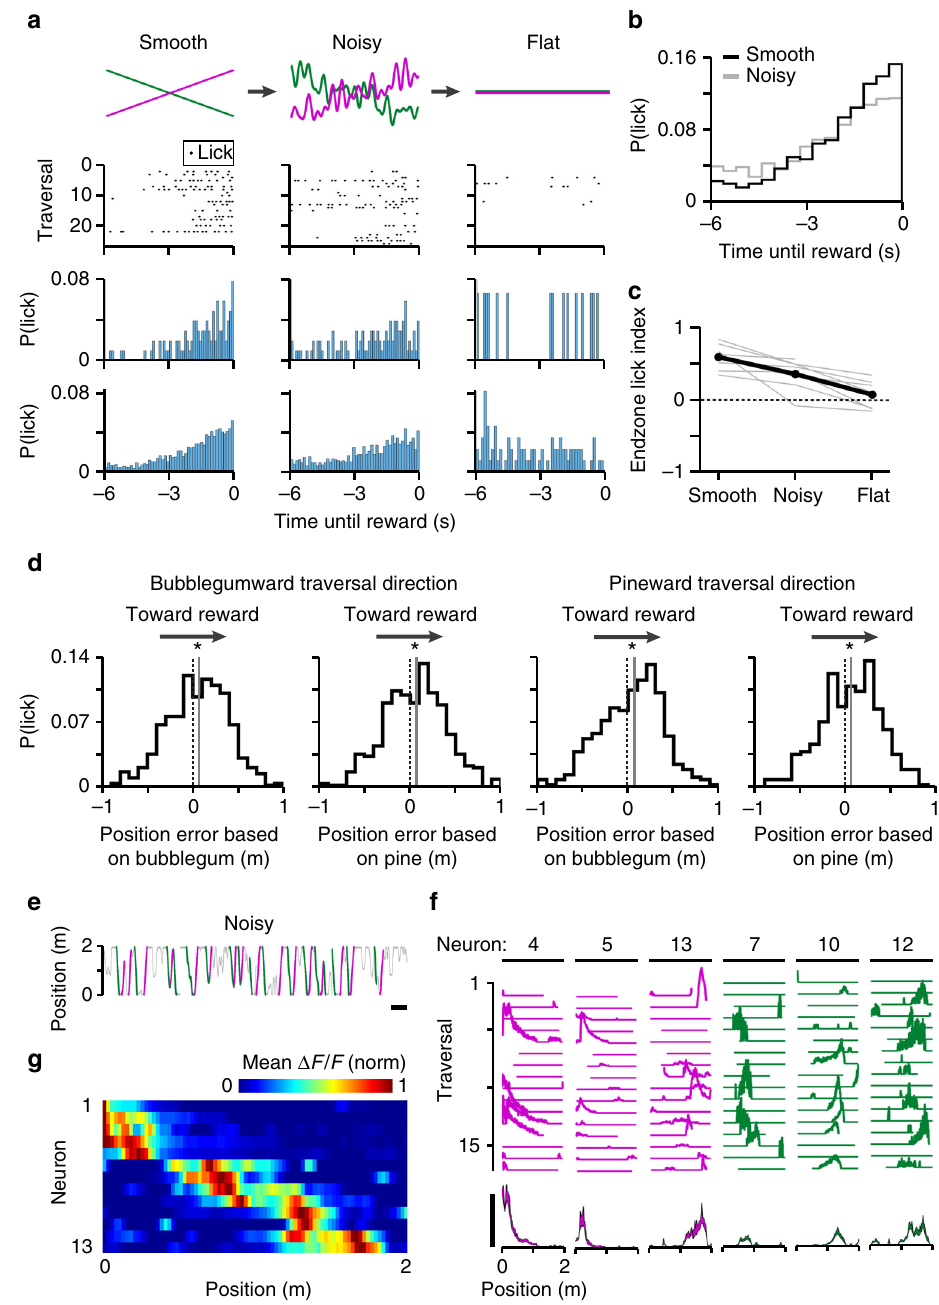
Fig. 6 Olfactory noise affects behavior and place cells are present during noisy odor navigation. a Mice were switched between familiar smooth, noisy, and fl at odor conditions (row 1). Example anticipatory licking raster plots (row 2) and corresponding histograms (row 3) for the same mouse in each condition. Pooled anticipatory licking histograms across all fi ve mice in eight sessions (row 4). b Overlaid anticipatory licking histograms from a bottom. Anticipatory licking was less precise and occurred earlier in the noisy vs smooth conditions. c Endzone lick index (Methods section) across conditions for all sessions (gray) and averaged (black). d Odor-based position errors bias anticipatory licking toward the reward site. Histograms are pooled across all fi ve mice in eight sessions. Medians (gray lines) of all distributions are signi fi cantly different form zero (dotted lines) (two-sided Wilcoxon signed-rank test, p = 0.0002 ( fi rst column), p = 0.0004 (second column), p = 0.0117 (third column), p = 0.0014 (fourth column)). e Position of a mouse behaving in the noisy condition. Scale bar = 1 min. f Traversal-by-traversal (top, arbitrary units) and mean change in fl uorescence (bottom, Δ F / F , mean ± s.e.m.) for six simultaneously recorded place cells during traversals in their preferred directions as indicated in e . Scale bar = 100% Δ F / F . g Mean Δ F / F as a function of track position for place cells identi fi ed in the noisy condition. Place cells were pooled across both running